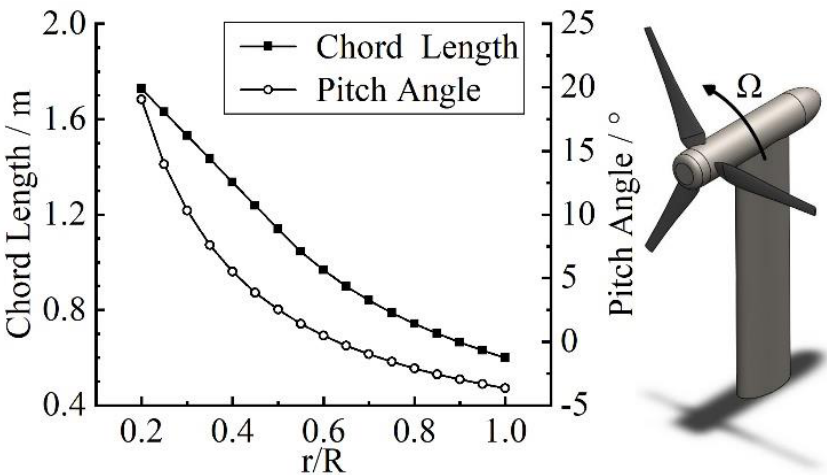
Figure 2. Detail of the blade and geometry of whole BHATT.